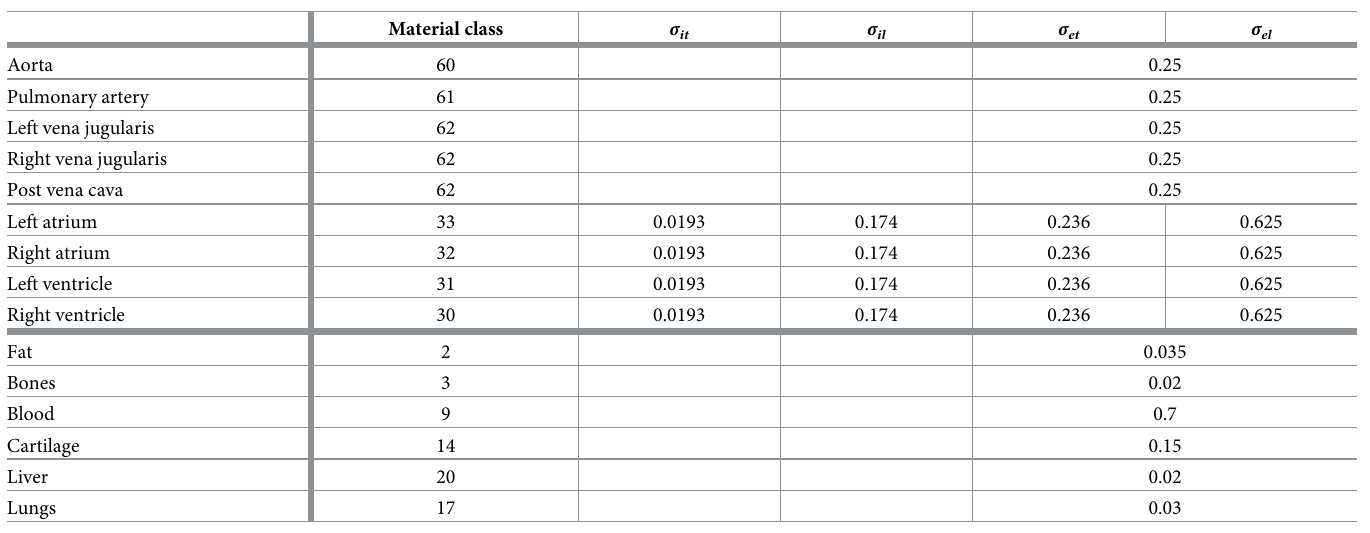
Table 1. Material classes and conductivities used to calculate the lead field